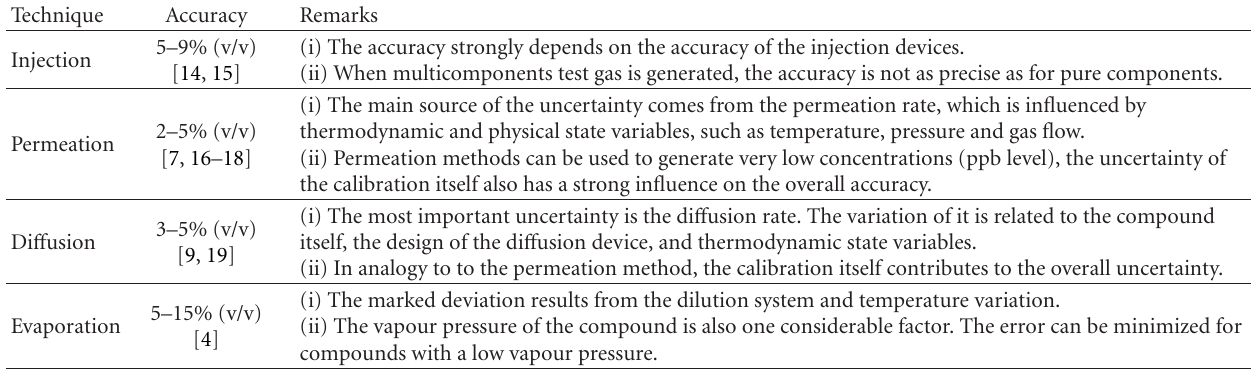
Table 1: Accuracy of test gas generated based on di ff erent methods.